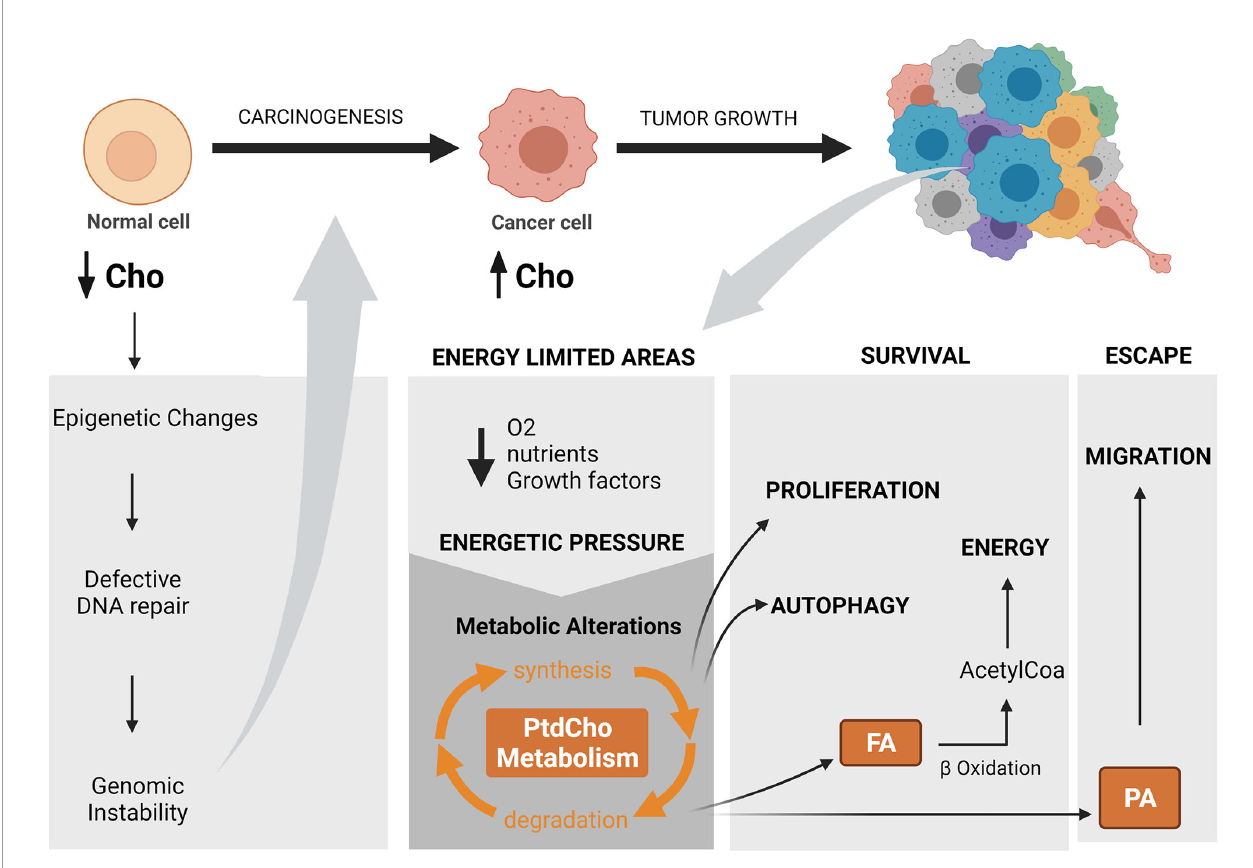
FIGURE 3 | The impact of altered choline metabolism in carcinogenesis and tumor progression. Altered choline metabolism promotes carcinogenesis through modulating DNA repair gene expression by methylation and generating genomic instability. Energy-limited areas arise with tumor growth and exert an energetic pressure that leads to metabolic reprogramming and results in diverse metabolic phenotypes. Altered choline metabolism is among these phenotypes. In particular, phosphatidylcholine metabolism regulates adaptative cellular processes, such as proliferation and autophagy that allow cancer cell survival with limited energetic sources and in parallel induce migration as an escape route toward an energy-privileged area. Cho, choline; PtdCho, phosphatidylcholine; FA, fatty acid; PA, phosphatidic acid; O 2 , oxygen.Created with